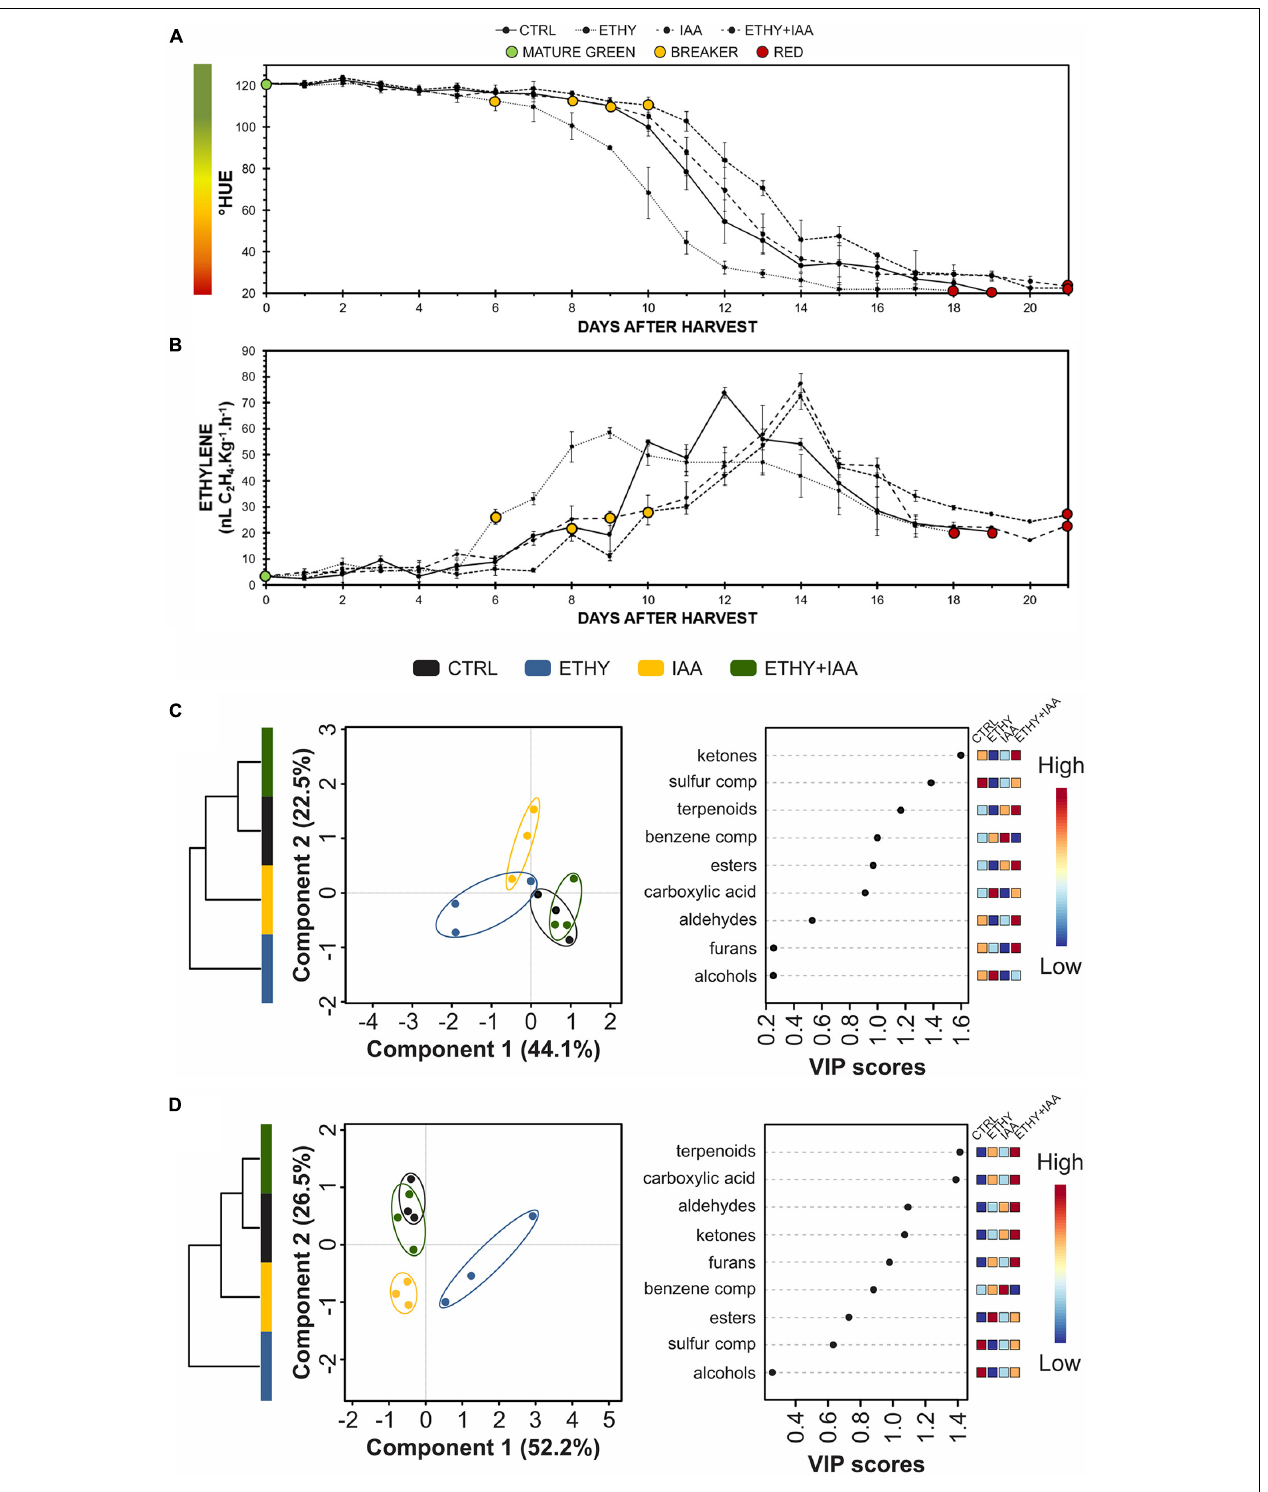
FIGURE 6 | Effects of ethylene, auxin, and both treatments on fruit color, ethylene emission, and VOC contents during Micro-Tom ( S. lycopersicum L.) fruit ripening. (A) Peel color expressed by hue angle. (B) Ethylene emission. (C,D) Hierarchical clustering, partial least squares discriminant analysis (PLS-DA), and variable importance in projection (VIP) of VOCs produced at breaker (C) and red (D) stages. CTRL, control group. ETHY, ethylene-treated group. IAA, indole-3-acetic acid-treated group. ETHY + IAA, group treated with both hormones. Vertical bars represent the standard deviation of three replicates ( n = 3).